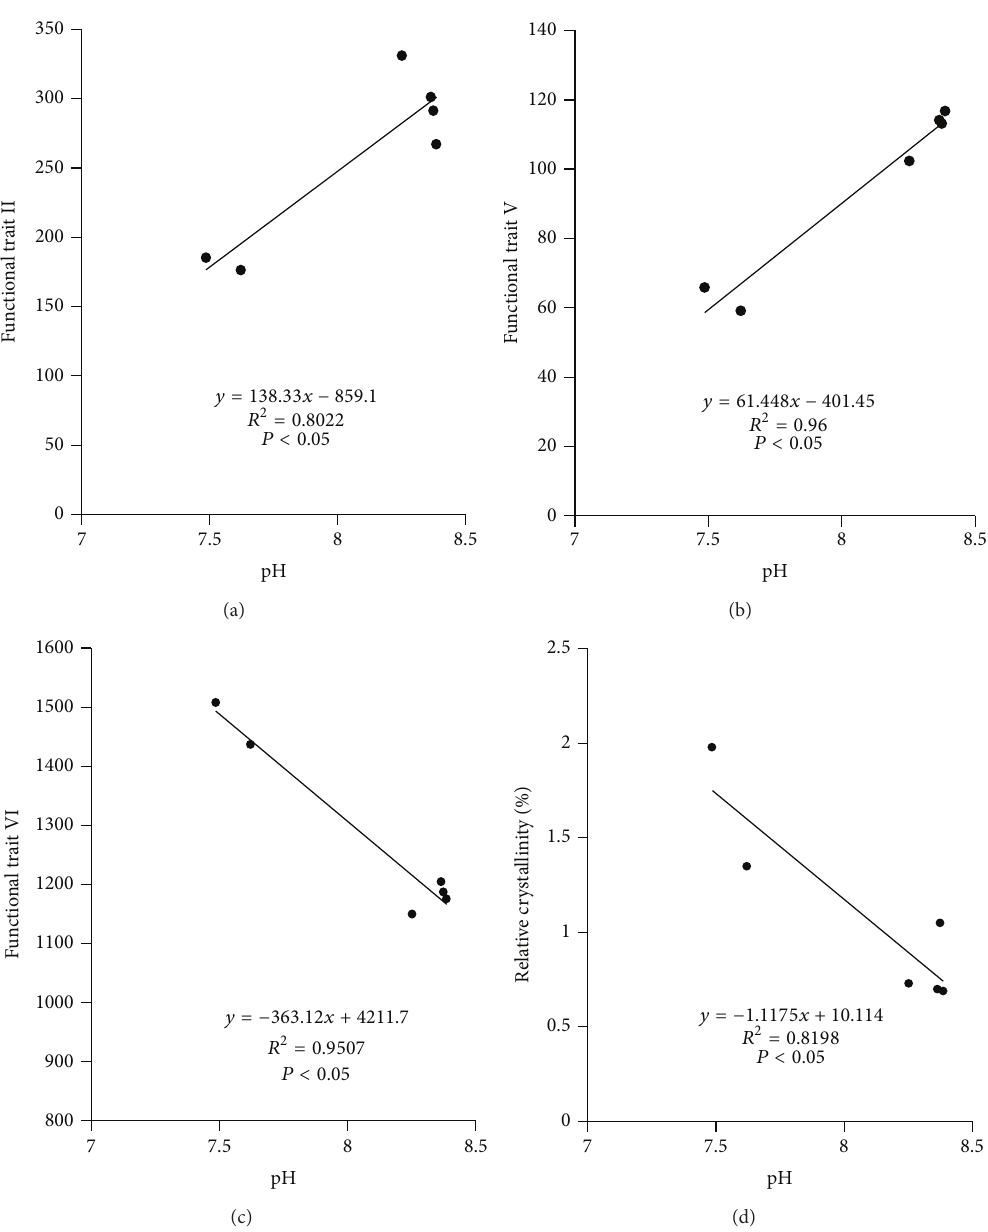
Figure 4: Correlations between soil pH and the concentration of functional trait II, V, VI, and relative crystallinity. Note: functional traits of II, V, and VI are the same as those in Figure